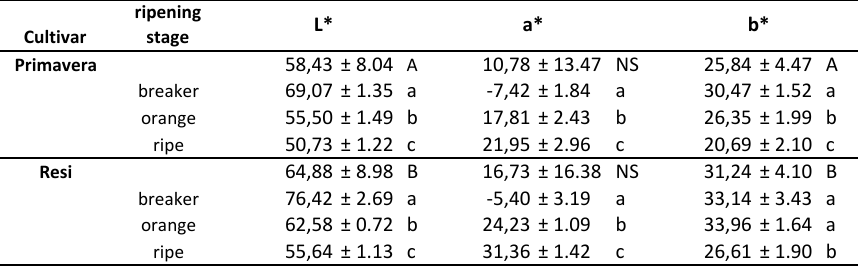
Mean values and standard deviation were determined from four biological replicates. Letters indicate statistically significant differences (statistical test: t-test). The level of significance was Table S7: Color values of the three ripening stages breaker, orange, and ripe in the two cocktail tomato cultivars grown in 2015.